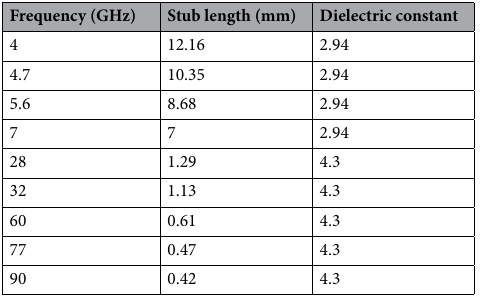
Table 2. Approximate lengths for low and high-frequency diplexer